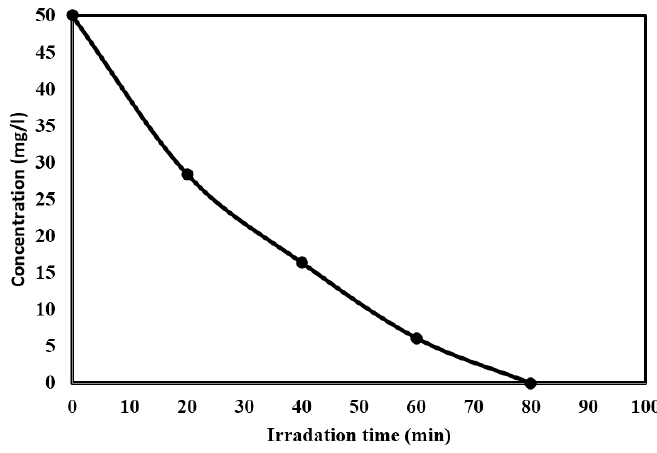
Figure 9. Photocatalytic degradation of chloroxylenol using TiO 2 NPs under optimal conditions.